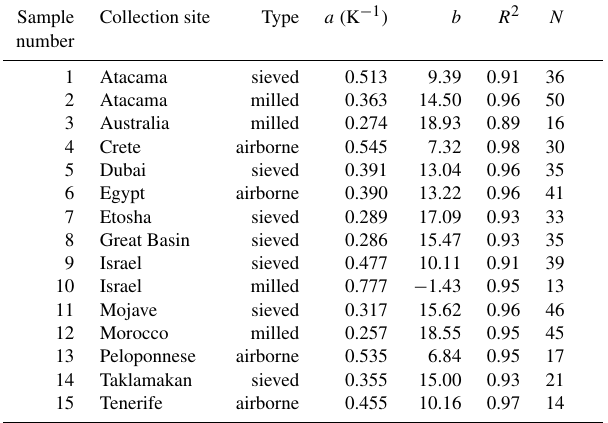
Table 4. Overview of the dust n s fit parameters a and b , the resulting R 2 , and the number of data points in each fit, N .